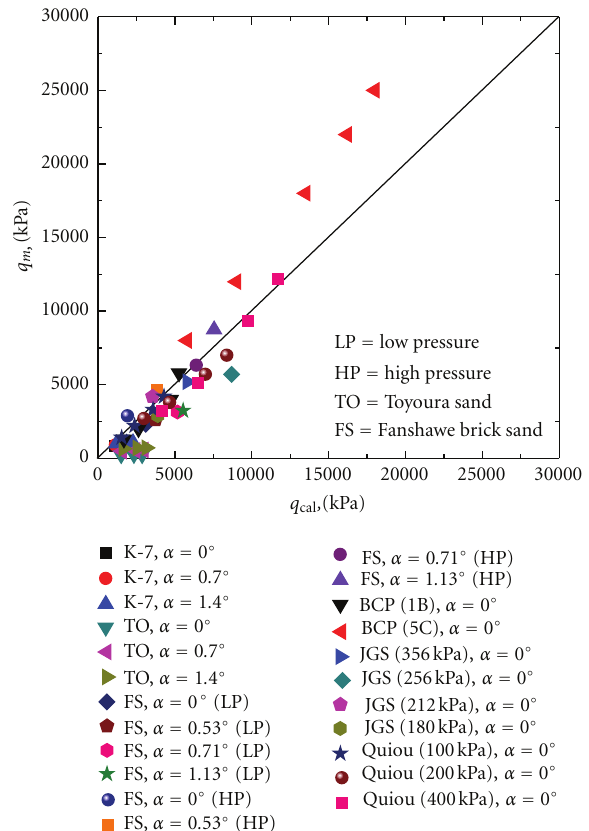
Figure 11: Calculated and measured end-bearing capacity of di ff er- ent types of